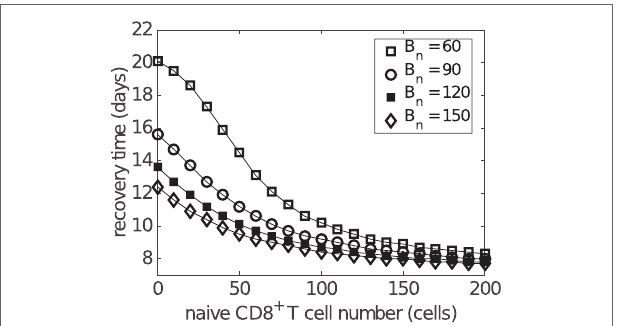
FIGURE 9 | Influence of antibody level on the relationship between the naive CD8 + T cell number and recovery time . Recovery time is defined to be the time when viral load falls to 1 EID 50 /ml. Different antibody levels are simulated by varying the initial number of naive B cells (i.e., B n at t = 0).